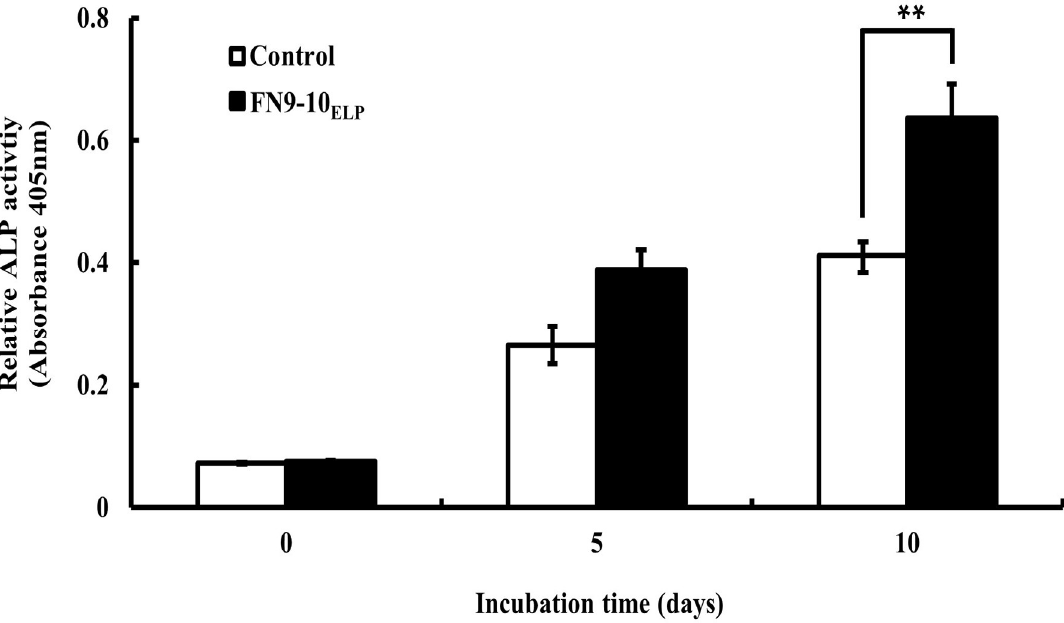
Fig 6. ALP activity of hMSCs on the FN9-10 ELP -titanium discs for 0, 5 and 10 days. The titanium discs were immersed in 10 μ g � mL − 1 FN9-10 ELP overnight at 4˚C, while the non-coated discs served as the control. The hMSCs were seeded at a density of 5 × 10 3 cells/disc and incubated for 0, 5 and 10 days at 37˚C. The ALP activities were normalized to the control and are reported as the mean ± SD (n = 3). p < 0.01.